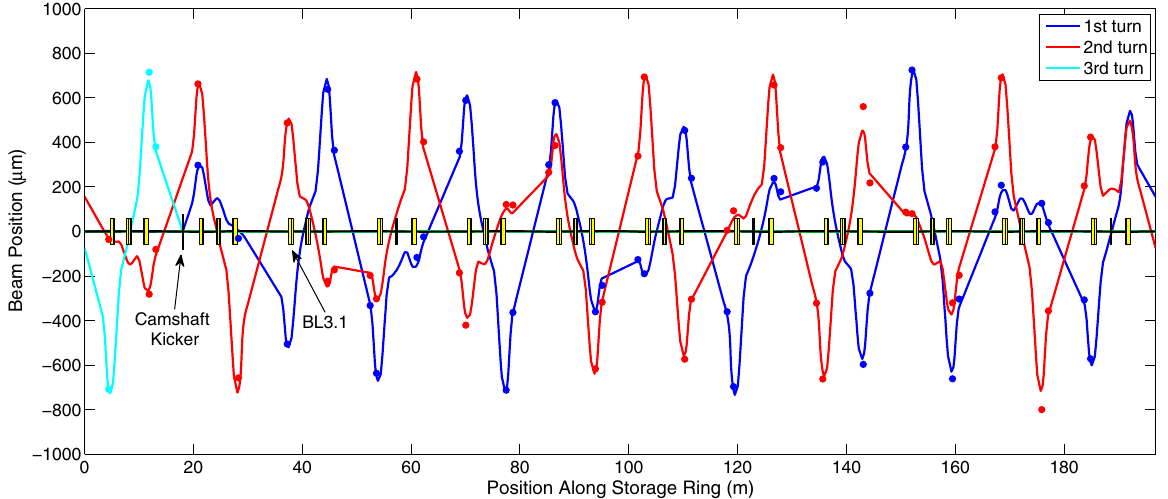
FIG. 4. Closed orbit of the KAC beam. The solid curves represent the simulation results and dots represent turn-by-turn BPM